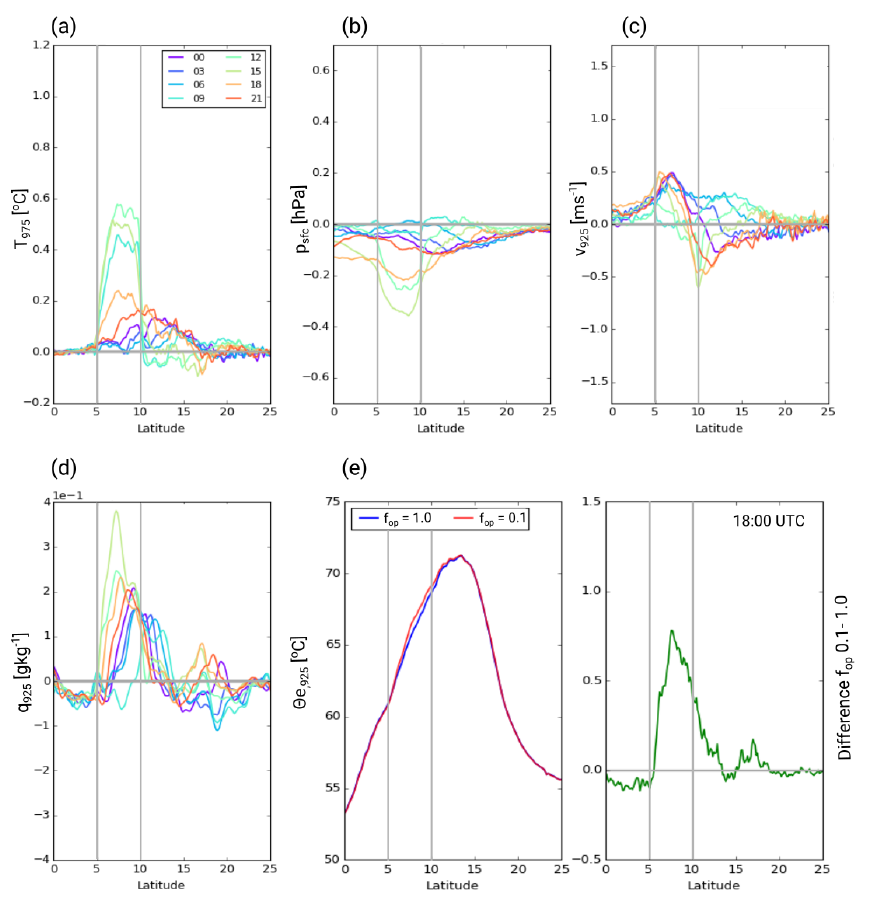
Figure 13. As Fig. 10 but for